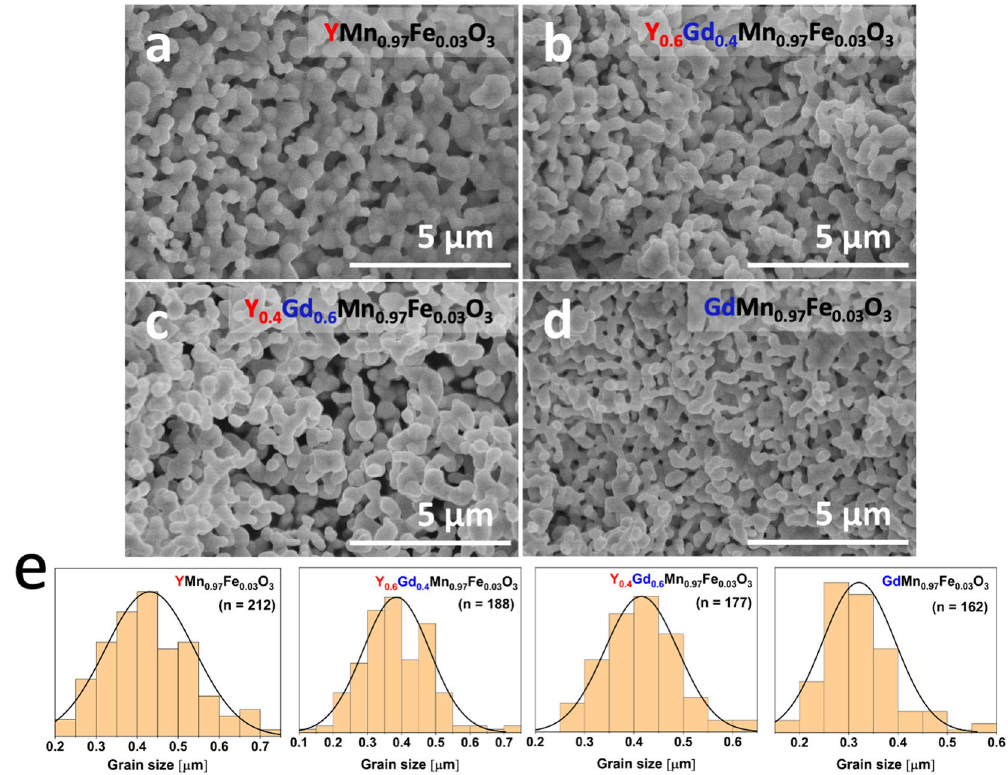
Figure 5. SEM micrographs of YMn 0.97 Fe 0.03 O 3 ( a ), Y 0.6 Gd 0.4 Mn 0.97 Fe 0.03 O 3 ( b ), Y 0.4 Gd 0.6 Mn 0.97 Fe 0.03 O 3 ( c ) and GdMn 0.97 Fe 0.03 O 3 ( d ) powders and histograms of grain sizes with corresponding derivatives of the cumulative distribution ( e ). Grain size distribution was calculated using ImageJ software (version 1.52 s, https ://image j.nih. gov).